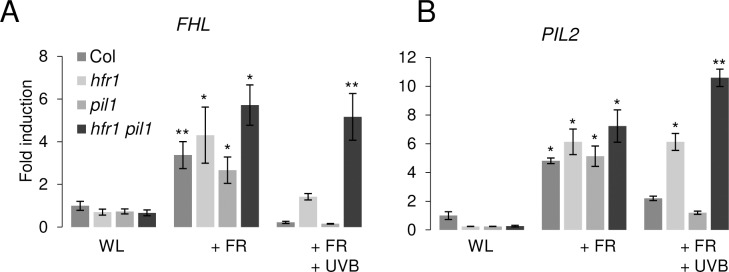
PIL1 and HFR1 act redundantly in UVR8-mediated repression of shade-induced FHL and PIL2 expression.(A, B) RT-qPCR analysis of (A) FHL and (B) PIL2 expression in 7-day-old seedlings of wild type (Col), hfr1-101, pil1-6, and hfr1-101 pil1-6 grown under constant white light (WL) and transferred to the indicated experimental light conditions for 3 h. Error bars represent SEM obtained from three biological replicates. Asterisks indicate the statistical significance compared to WL in each genotype (* p < 0.05; ** p < 0.01).